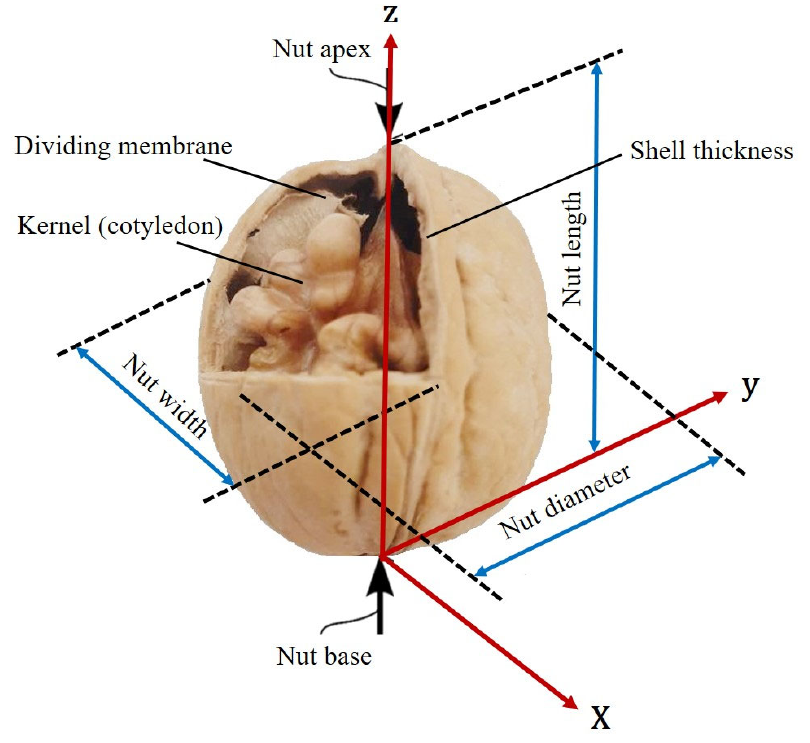
Figure 2. Dry fruit of Persian walnut ( Juglans regia ).